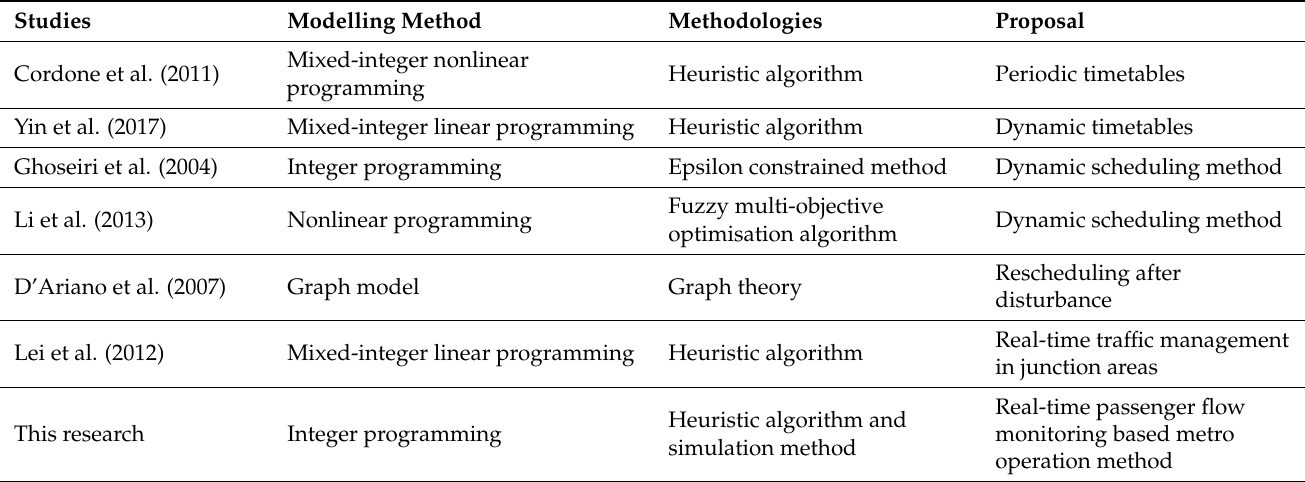
Table 1. Comparisons of representative metro operation